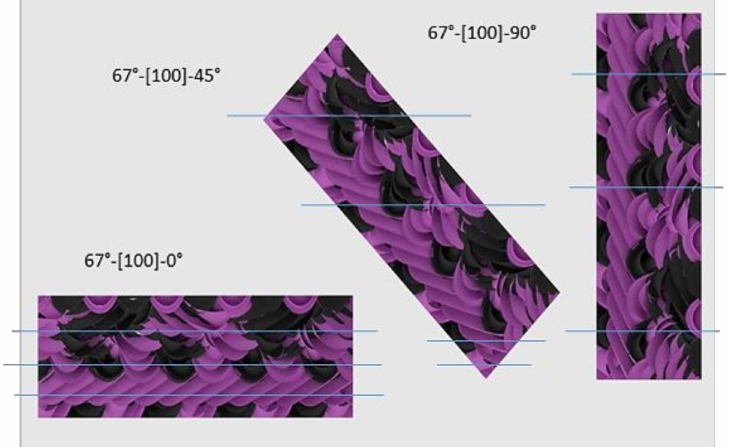
Figure 10. The three RVE models after the boundaries were removed.